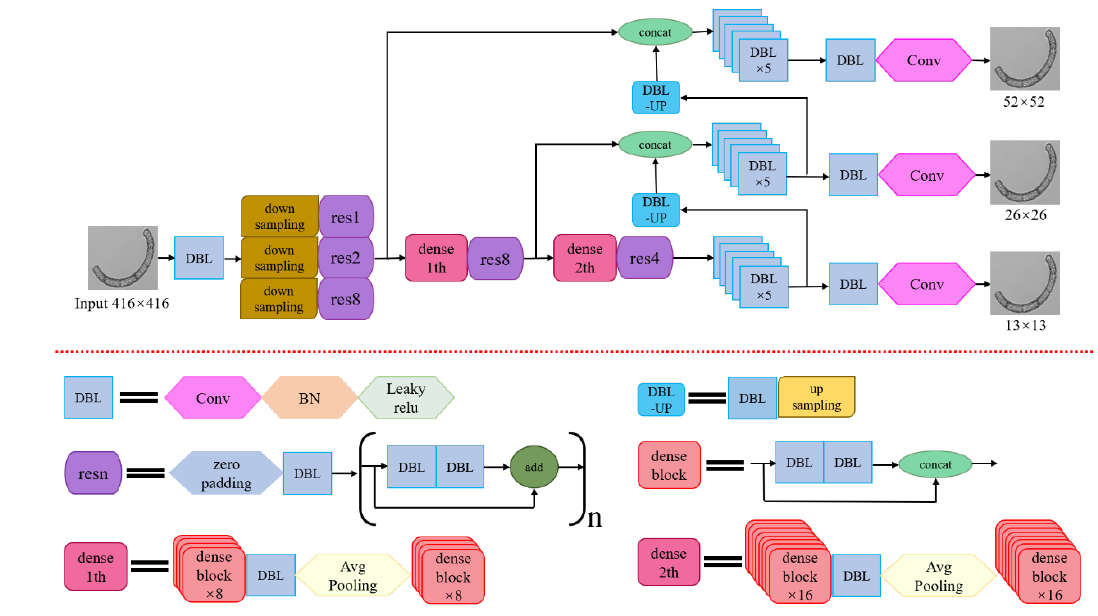
Figure 5. Complete network structure of the proposed YOLOV3-dense model.